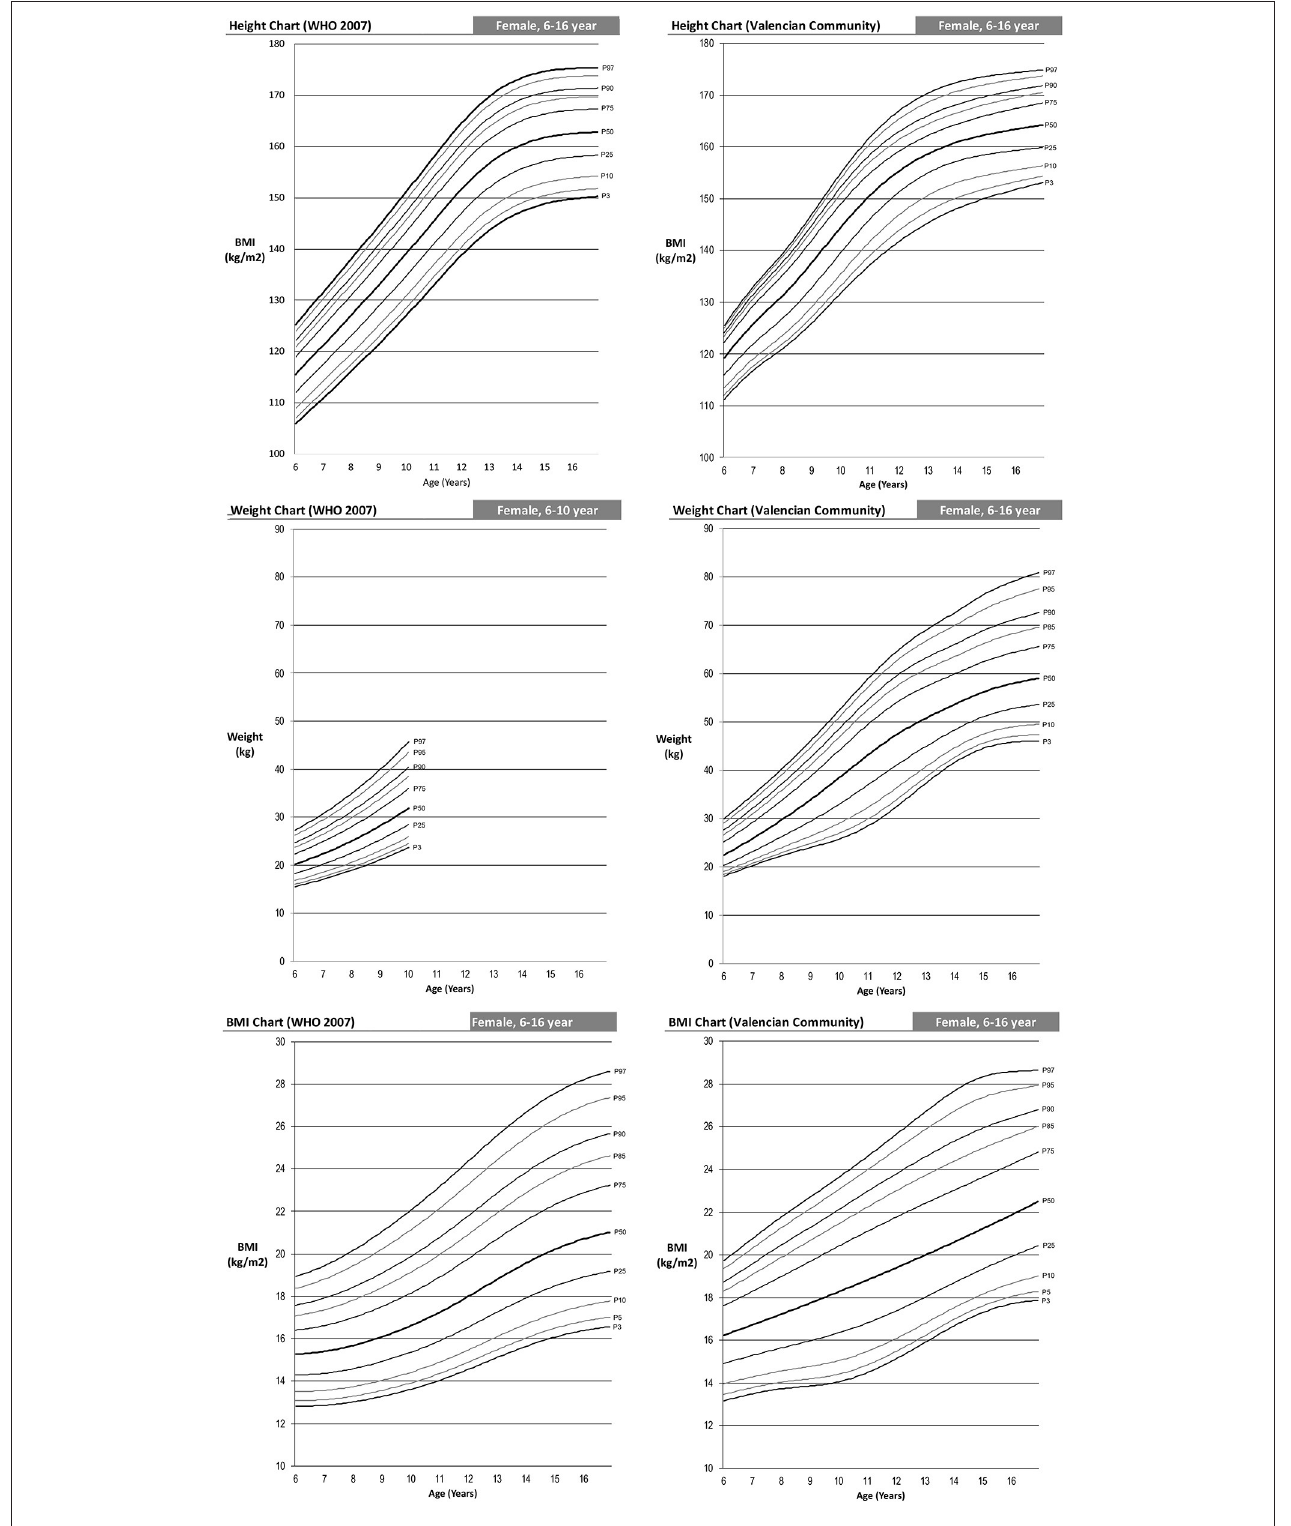
FIGURE 3 | WHO 2007 and Spanish-eastern children female reference